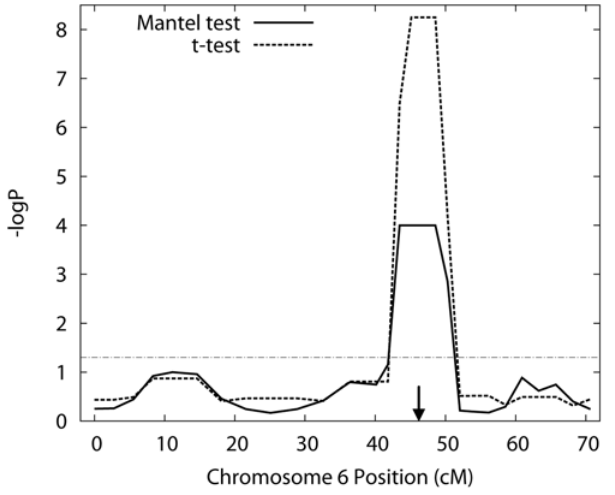
Figure 4. Plot of p-values obtained by the FPL method for psoriasis on the chromosome 6 using 750 unrelated Japanese individuals. The horizontal line represents the 0.05 level, and the arrow represents the position of the marker D6S2931 which is located in the PSORS1 locus. { log 10 of the p-values by the Mantel test and the t- test of the regression are